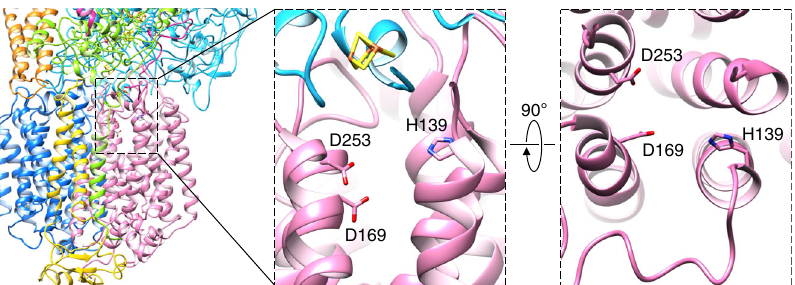
Fig. 5 Quinol-binding site. Putative quinol-binding site on the periplasmic side of ActC (left), with zoomed views of conserved residues involved in quinol coordination, seen from the membrane (center) and from the periplasm (right). Subunits colored as in Fig. 1. Note that density for aspartate residues is not visible and their side chains have been